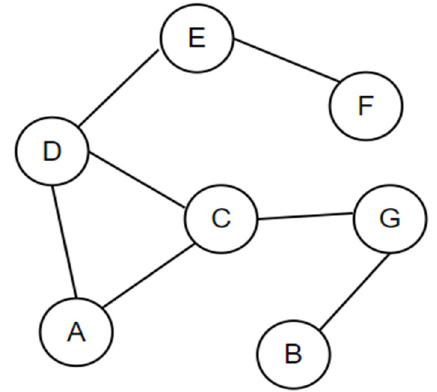
Figure 1. Nodes and edges in a graph structure.